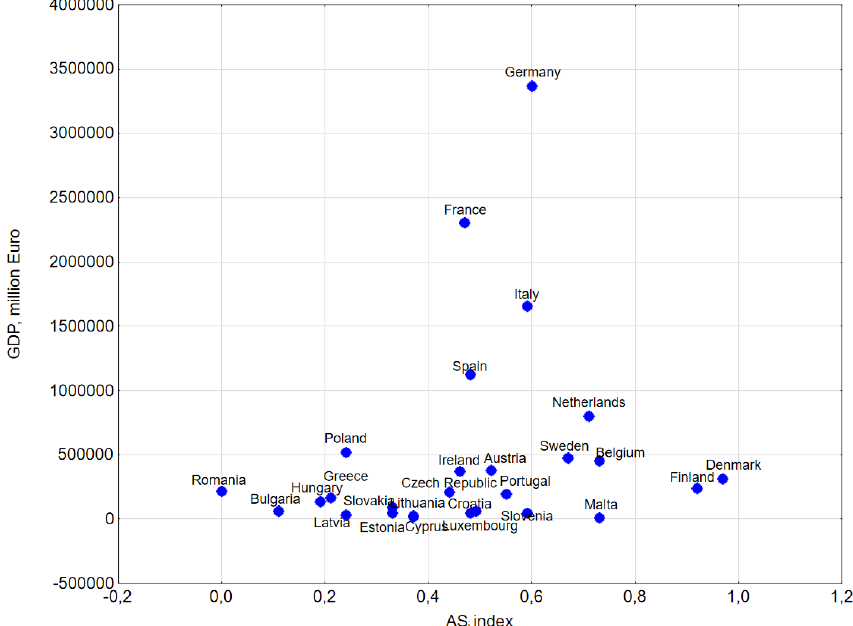
Figure 9. The relationship between the GDP of the EU-27 countries and the value of digital maturity index of their SMEs.